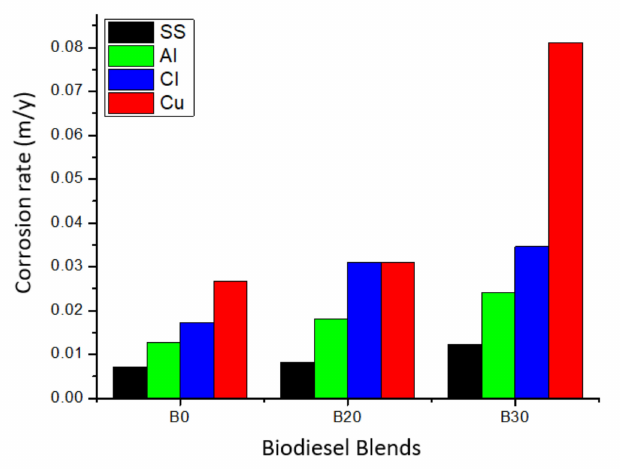
Figure 2. The comparative corrosion rate of different materials using the immersion test at 80 ◦ C for 1600